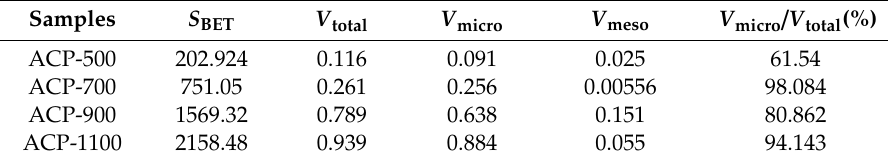
Figure 2. ACP N 2 adsorption and micro porosity. ( a ) Experimentally measured adsorption-desorption isotherms and ( b ) computed micro-pore size distributions. Table 1. Pore properties of ACP samples calculated from N 2 adsorption measurement.